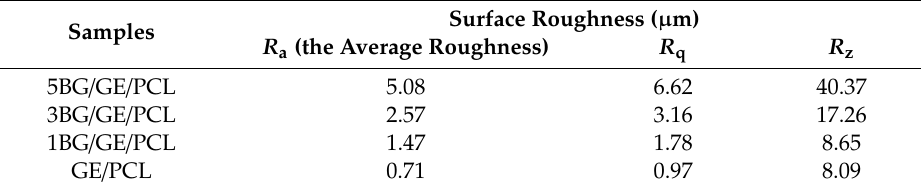
Figure 4. The surface roughness diagram of different samples. Table 2. The results of the surface roughness of different samples.